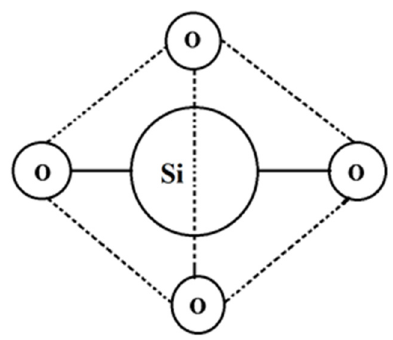
Figure 8. Chemical structure of glass fiber [82].